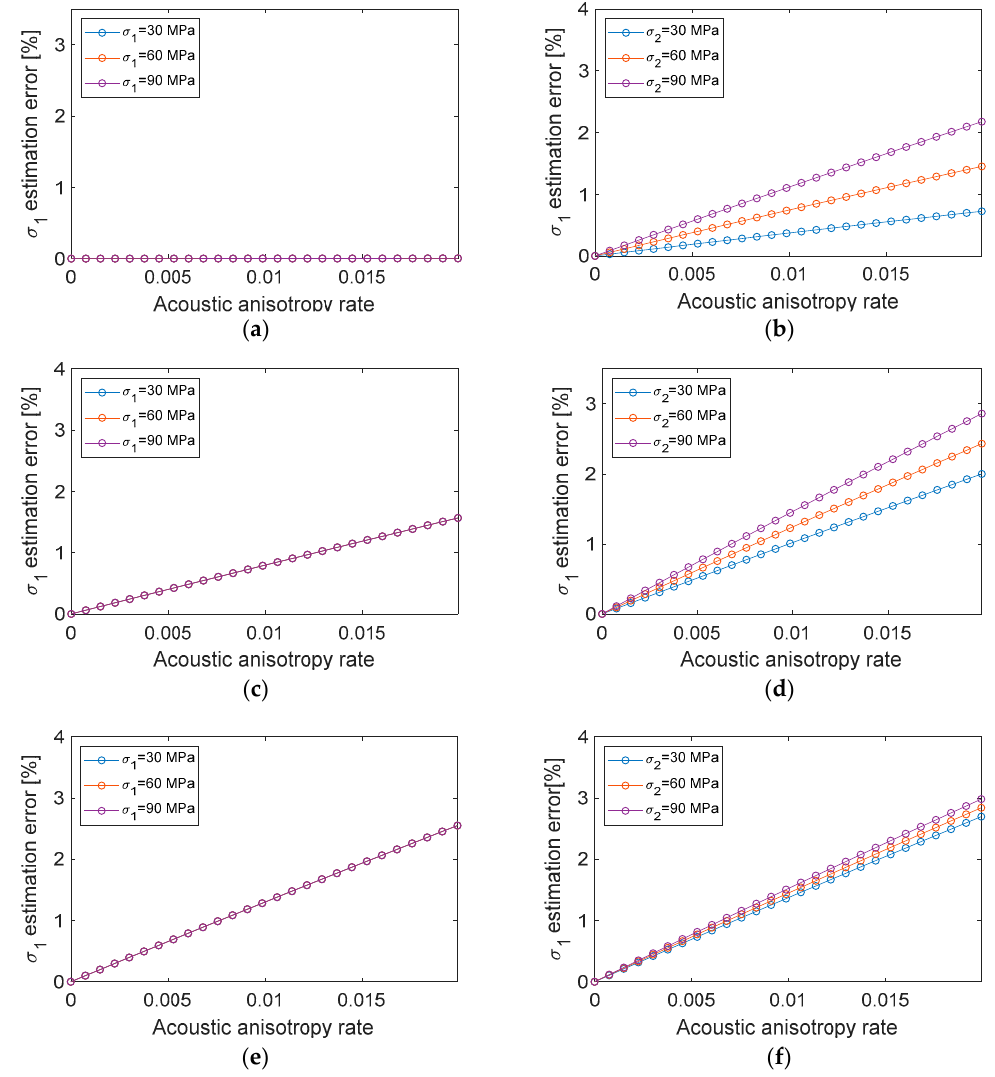
Figure 5. Stress estimation errors of the proposed method with respect to the anisotropy rate ( a ) Case 1A; ( b ) Case 1B; ( c ) Case 2A; ( d ) Case 2B; ( e ) Case 3A; ( f ) Case 3B.